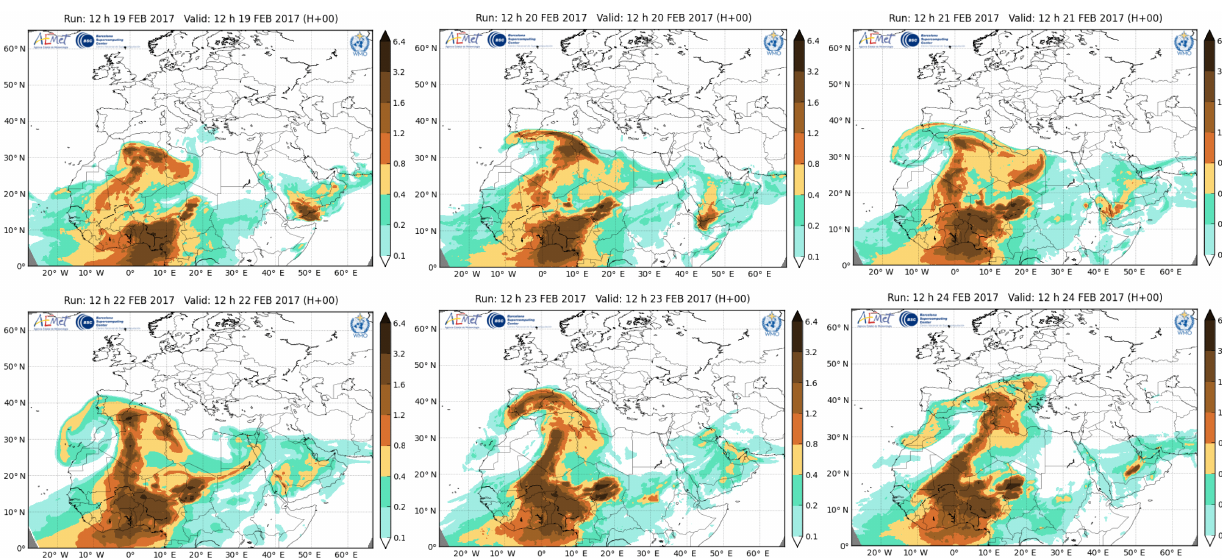
Figure 2. NMMB-BSC dust forecast aerosol optical depth (AOD) at 550nm for the days before, during, and after the extreme red rain event. Images from the Barcelona Dust Forecast Center.